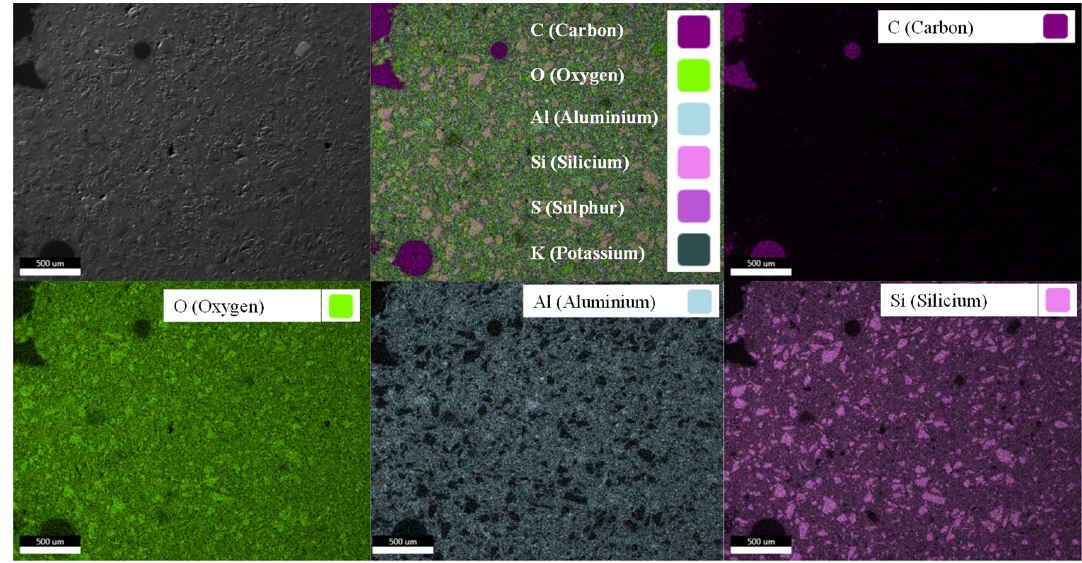
Figure 5. SEM-EDX elemental mapping of epoxy resin embedded cross-section of pristine Geopolymer MK54, i.e., before exposure to sulfuric acid (superposition of elements in the top center image; SEM image in top left image).